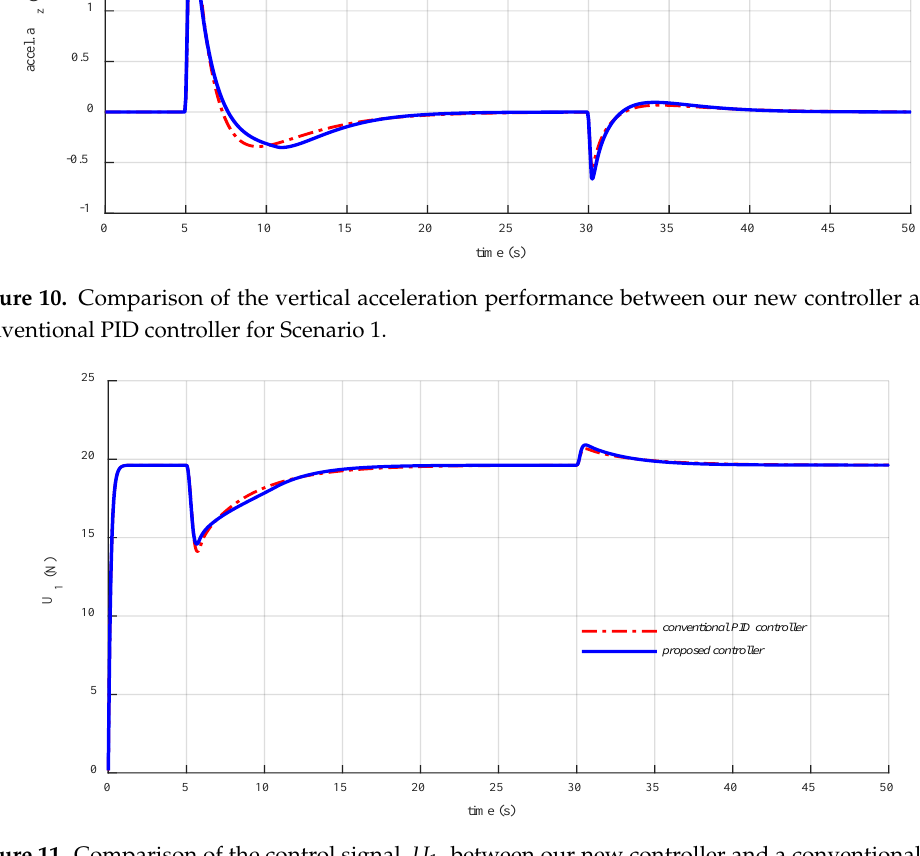
U , between our new controller and a conventional PID 1